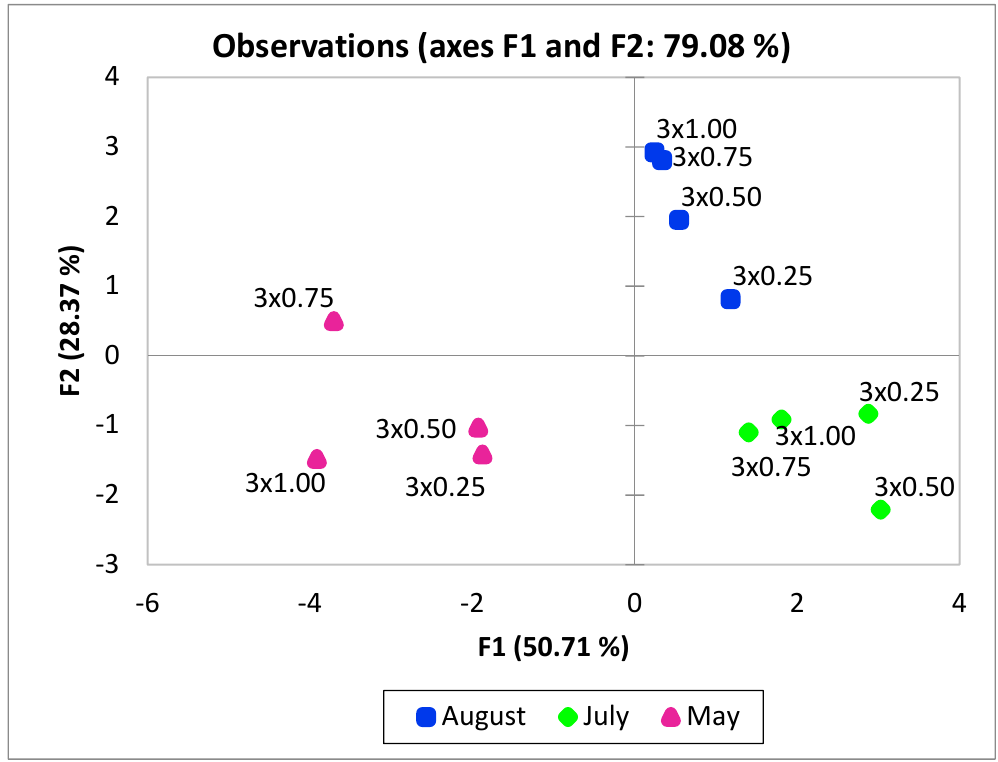
Figure 8. The PCA scatterplot, indicating distinct differences in photosynthetic rate, stomatal conductance, transpiration rate, soluble sugars, total starch and photosynthetic pigments depending on the planting distances.